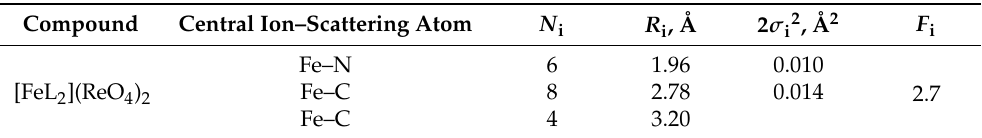
Table 2. Microstructure parameters for complex [FeL 2 ](ReO 4 ) 2 in the LS state obtained by single- scattering EXAFS data